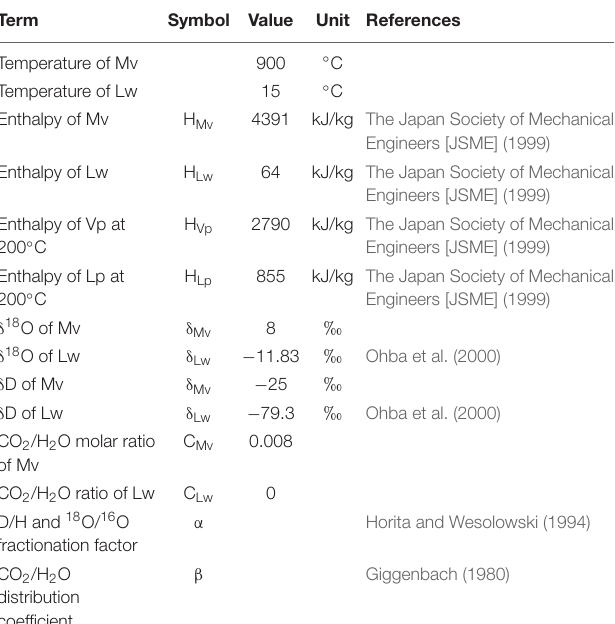
TABLE 3 | Parameters used for the model calculation generating